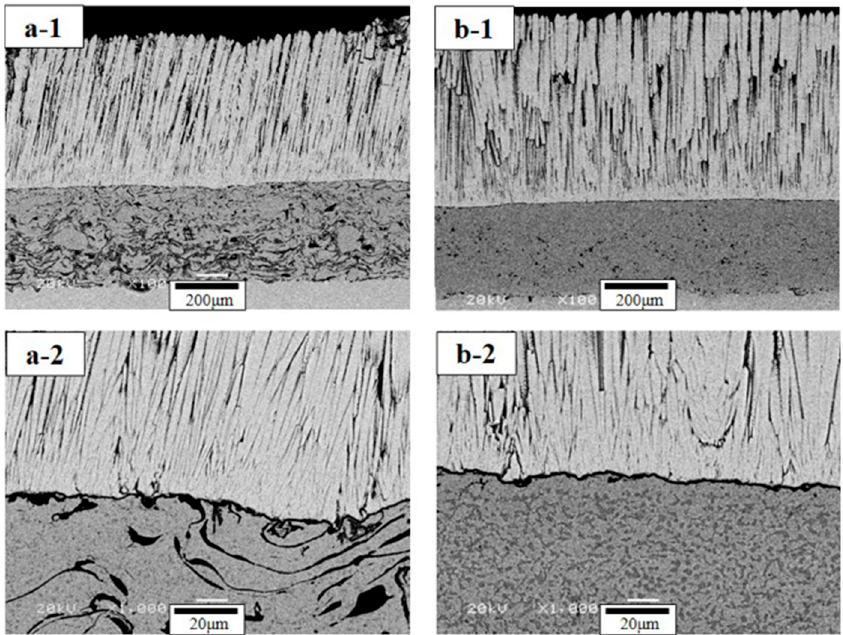
Figure 2. Cross-sectional microstructures of TBC system after FTF tests: APS bond coat TBC system (the overall ( a–1 ) and the interface ( a–2 ) microstructures) and HVOF bond coat TBC system (the overall ( b–1 ) and the interface ( b–2 ) microstructures).